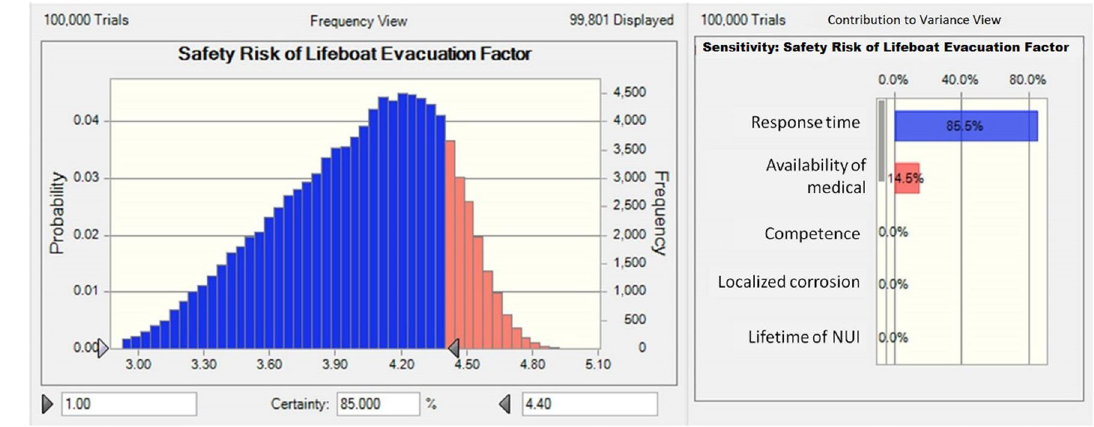
Fig. 5 Safety risk of lifeboat evacuation for a type A platform